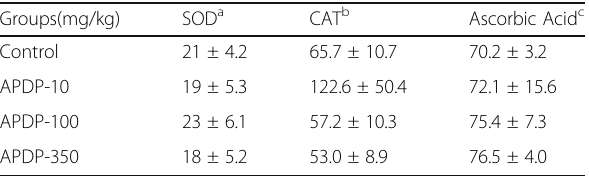
Table 3 Effect of